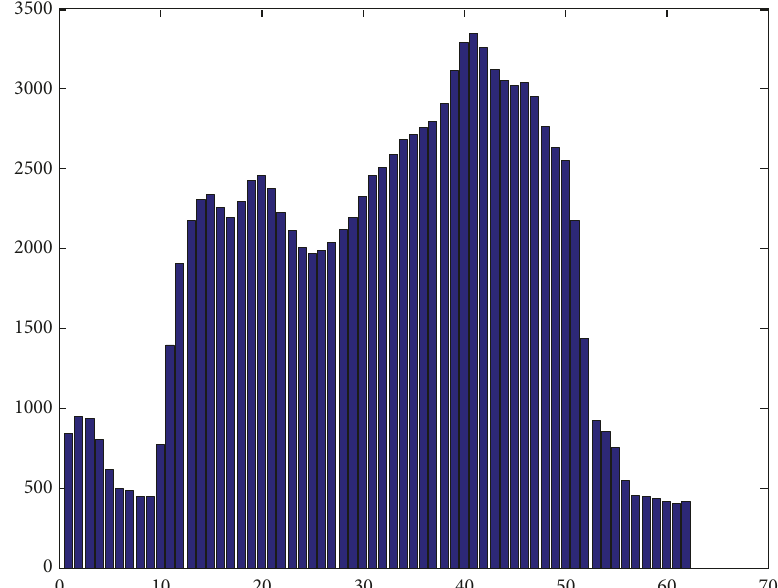
Figure 4: Histogram of horizontal integral projection.